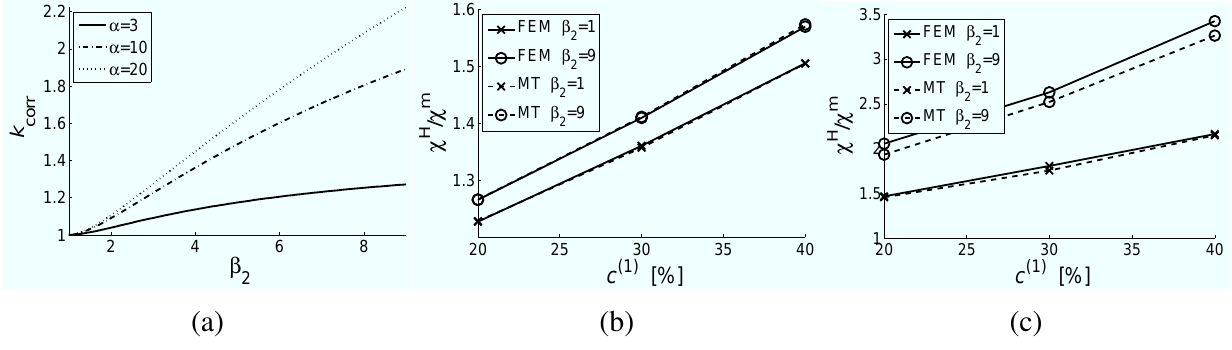
Figure 8. ( a ) Evolution of correction factor k a function of the ratio of semi-axes β χ H /χ m obtained by FEM and MT with modified conductivity ( b ) α = 3 and ( c ) α = 20